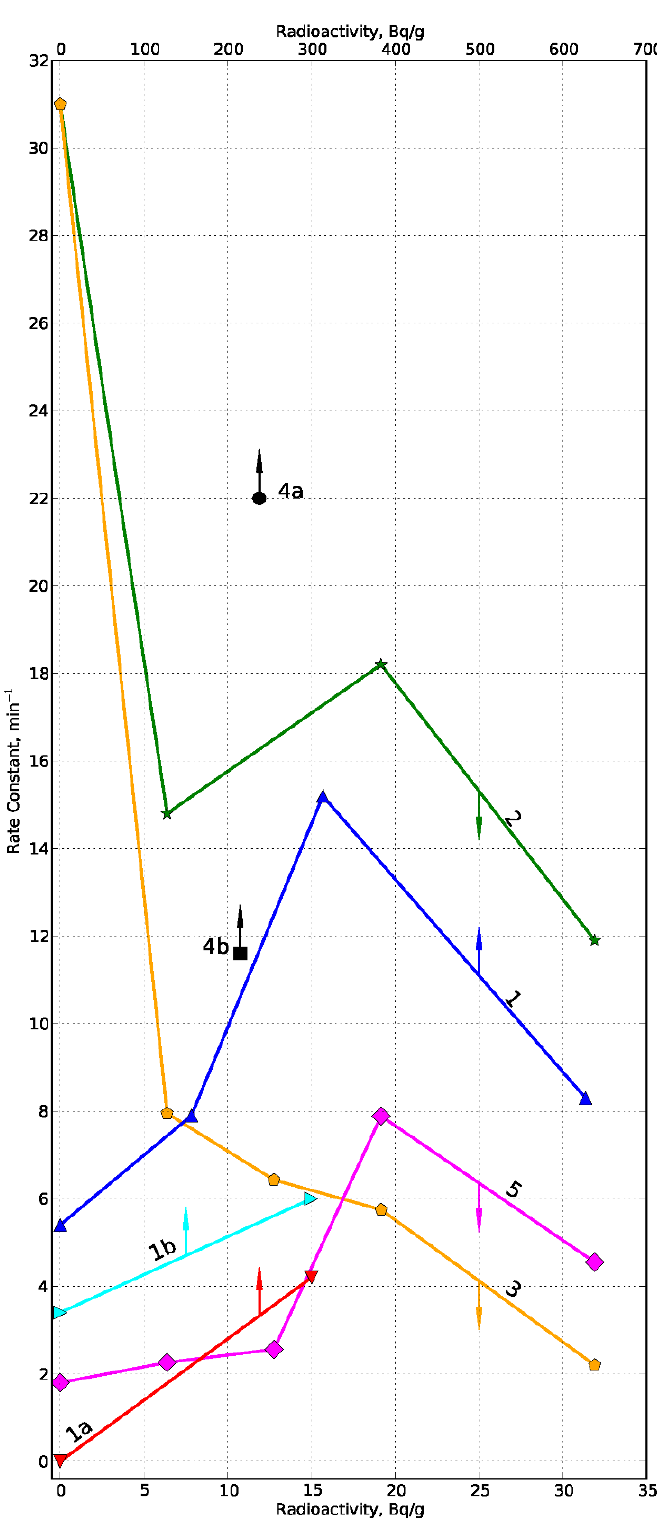
Figure 4. Degradation rate constant in dependence on the sample radioactivity under UV-irradiation according to: present paper for Malachite Green as pollutant: pure TiO prepared at 550 o C (1), TiO -Ce (1b); [4] for Chlorpyrifos (2); [5] for Oryzalin (3); [6] for Methylene Blue (4a) 2 2 and phenol (4b); under solar illumination for Oryzalin [5] (5) and in dark (present paper, pure TiO prepared at 700 o C) 2